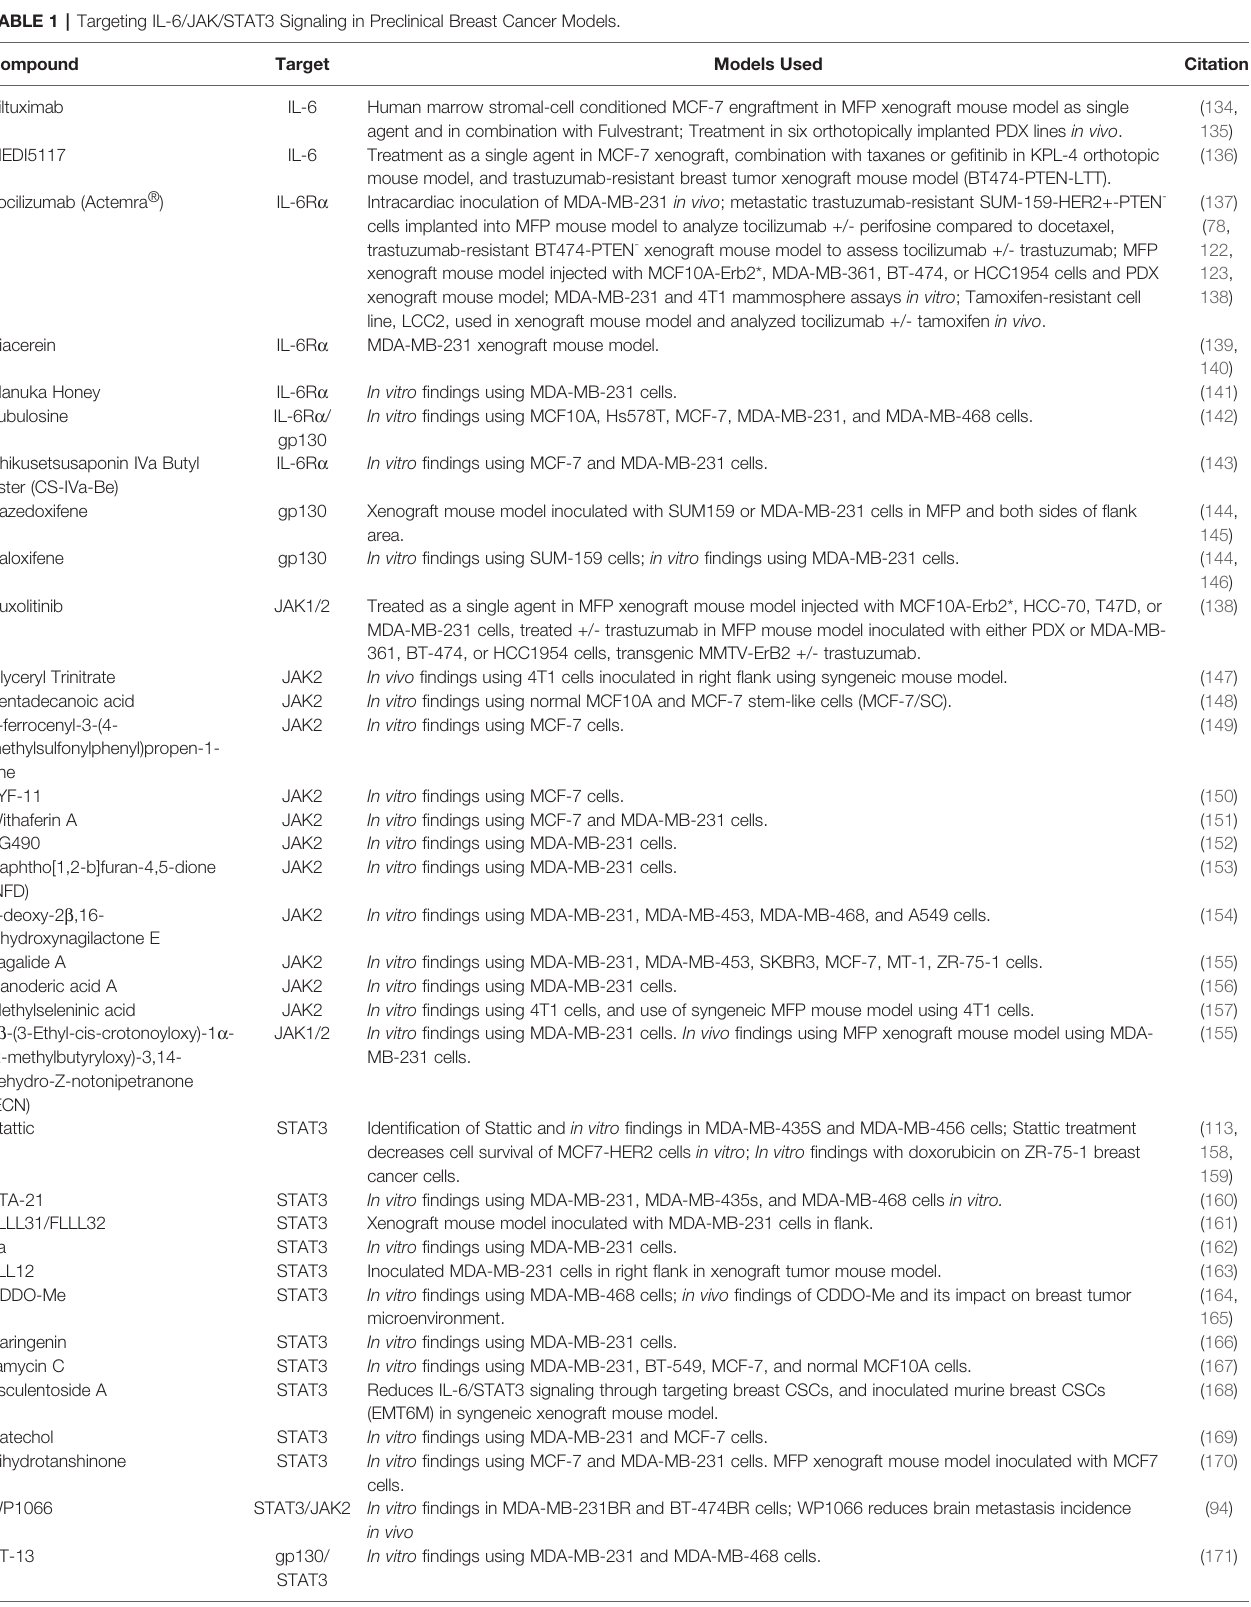
TABLE 1 | Targeting IL-6/JAK/STAT3 Signaling in Preclinical Breast Cancer Models. Compound Models Used